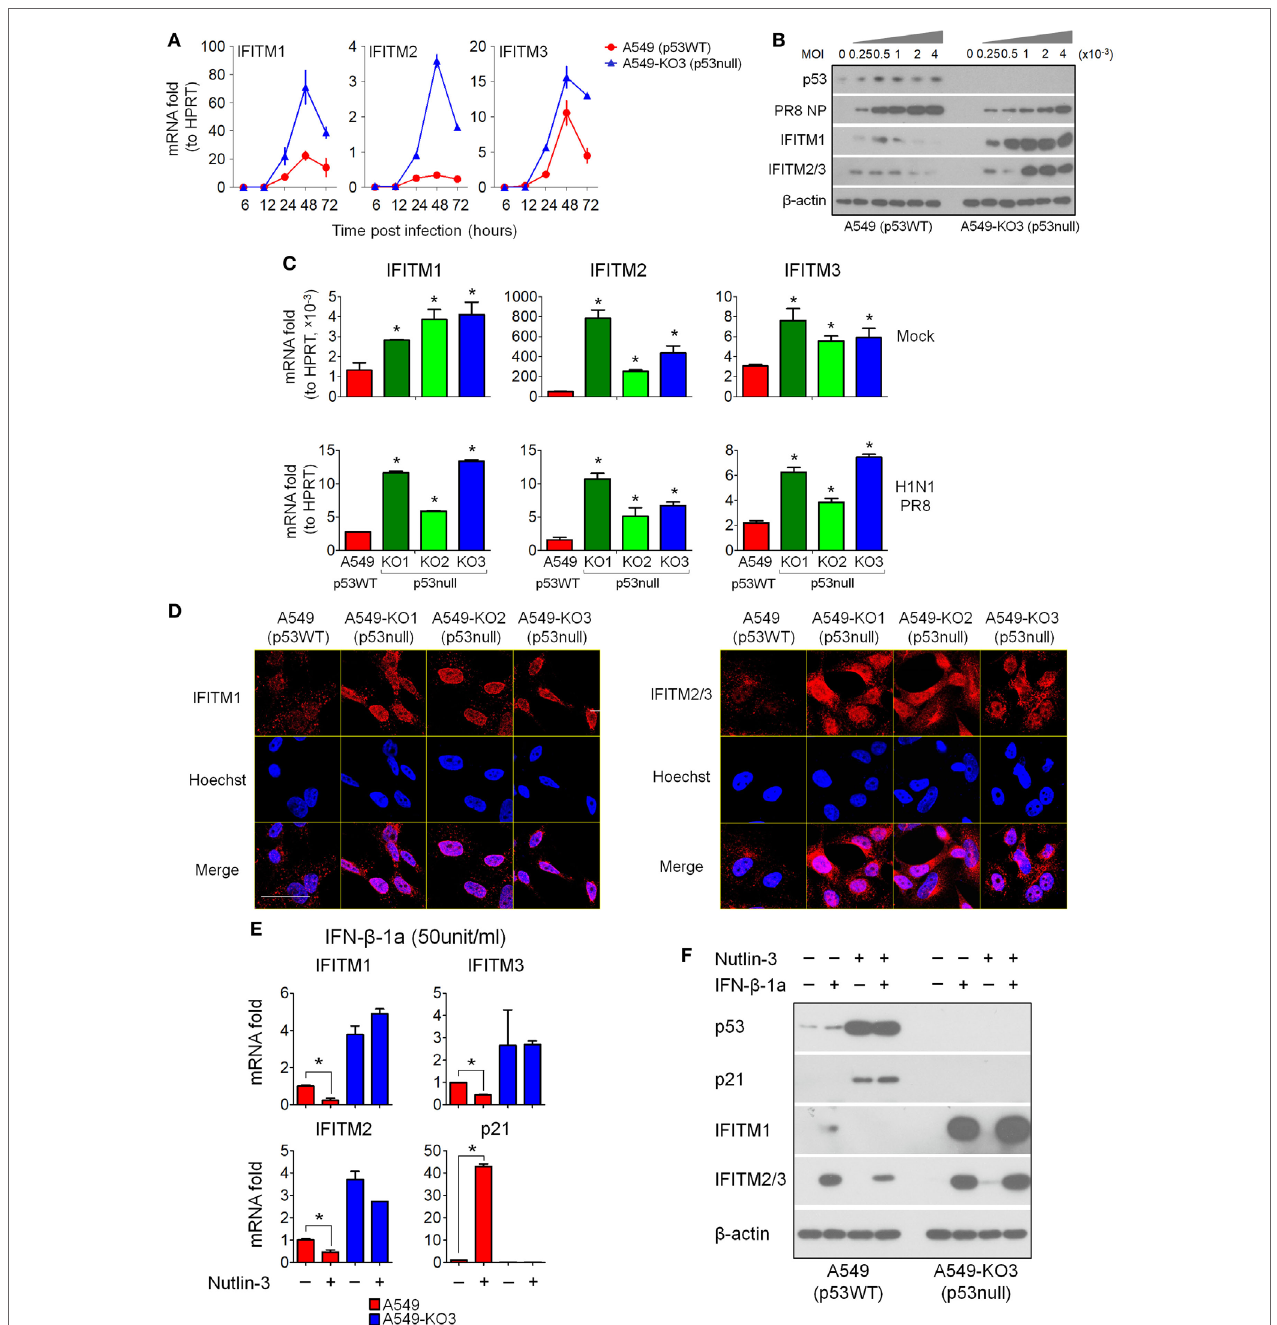
FigUre 5 | Interferon-induced transmembrane proteins (IFITMs) expression is highly induced by IAV infection and interferons in p53null cells compared with p53WT A549 cells. (a) Expression levels of the top 3 most differentially expressed genes (IFITM1, IFITM2, and IFITM3) from the 50 overlapping gene set ( Figure 3F ) were validated by real-time quantitative PCR (RT-qPCR) validation in IAV-infected A549 and A549-KO3 cells [multiplicity of infection (MOI) = 0.001] at the indicated time points. (B) Western blot analysis of expression of viral nucleoprotein (NP), p53, IFITM1, and IFITM2/3 in p53WT A549 and p53null A549-KO3 cells 24 h post-IAV infection at a range of MOI. β -actin blotting was used as a loading control. (c) RT-qPCR analysis of IFITM1, IFITM2, and IFITM3 expression level in mock- or IAV-infected p53WT A549, p53null A549-KO1, A549-KO2, and A549-KO3 cells (MOI = 0.001) at 24 h post-infection. * p < 0.05. (D) Immunofluorescence microscopy images of IFITM1 and IFITM2/3 expression in IAV-infected p53WT A549, p53null A549-KO1, A549-KO2, and A549-KO3 cells (MOI = 0.001) at 24 h post-infection. Scale bar, 20 µm. (e) RT-qPCR analysis of IFITMs mRNA expression level in interferon- β 1a (IFN- β -1a) treated p53WT A549 and p53null A549-KO3 cells pretreated with Nutlin-3 or DMSO solvent control. * p < 0.05. (F) Western blot analysis of IFITM1, IFITM2/3, p53, and p21 protein expression level in IFN- β -1a treated p53WT A549 and p53null A549-KO3 cells pretreated with Nutlin-3 or DMSO solvent control. β -actin blotting was used as a loading control. For panels (e,F) , both A549 and A549-KO3 cells were treated with Nutlin-3 (25 µM) or DMSO for 6 h, followed by IFN- β -1a treatment (50 U/ml) for another 24 h.